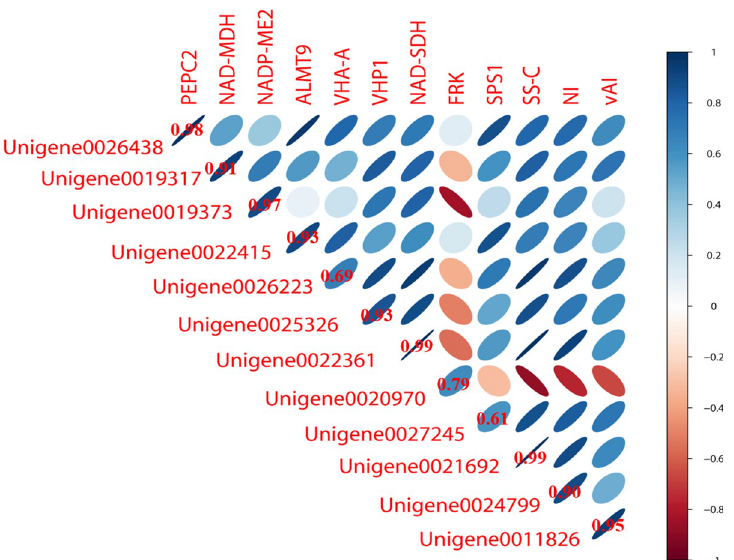
Fig 6. Validation of digital gene expression using quantitative real-time PCR. The stronger the correlation, the more flat the ellipse.